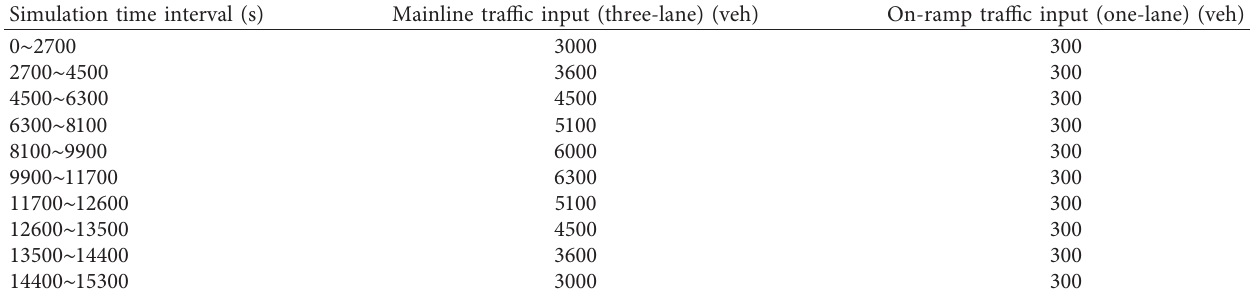
Table 4: Traffic input in a scenario.